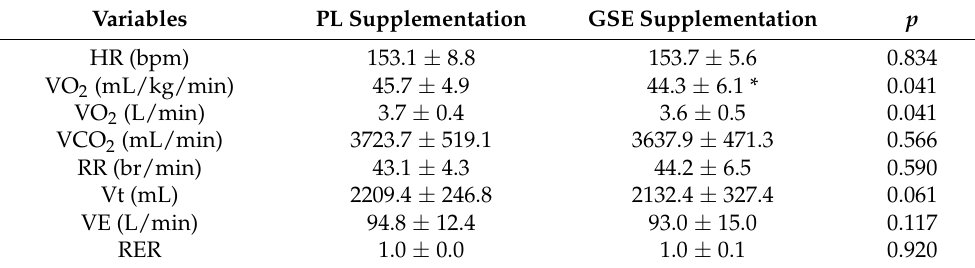
Table 4. Cardiorespiratory responses during the submaximal exercise of 80% of VO 2peak after PL and GSE supplementation.